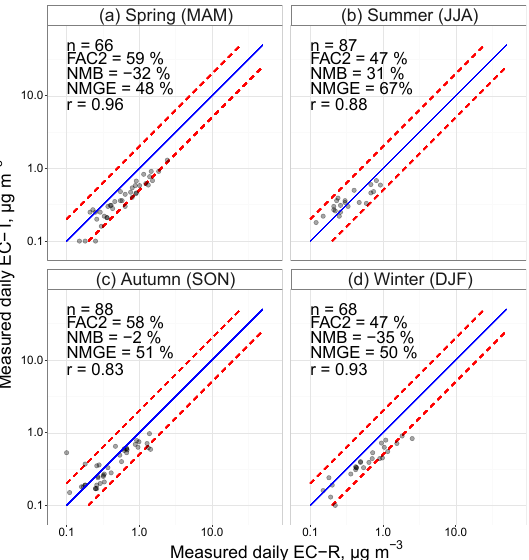
Figure A2. Scatter plot of measured daily average EC split from TC using transmittance (EC-T) and EC split from TC using reflectance (EC-R) at the Harwell site split by seasons, year